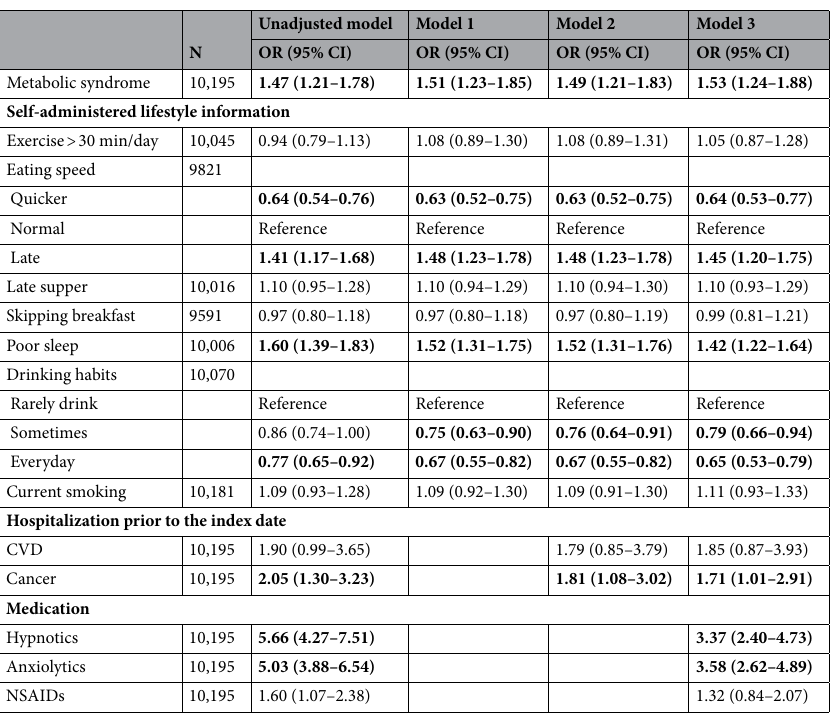
Table 3. Factors associated with the initiation of antidepressants. Bolded letters represent P values less than 0.05. OR odds ratio, CI confidence interval, BMI body mass index, SBP systolic blood pressure, DBP diastolic blood pressure, HDL high-density lipoprotein, LDL low-density lipoprotein, BW body weight, IHD ischemic heart disease, CVD cardiovascular disease, CHF congestive heart failure, NSAIDs non-steroidal anti- inflammatory drugs.